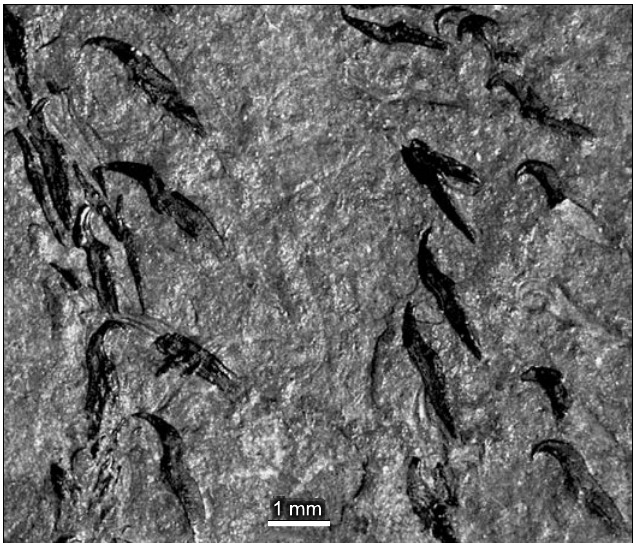
Fig. 15. Coleoid cephalopod Phragmoteuthis bisinuata (Bronn, 1859) (GBW 2006/011/0001); lower Carnian, Upper Triassic, Cave del Predil, NE Italy. Arm hooks with basal parts longer than shafts saving in-life paired arrangement along the arms.